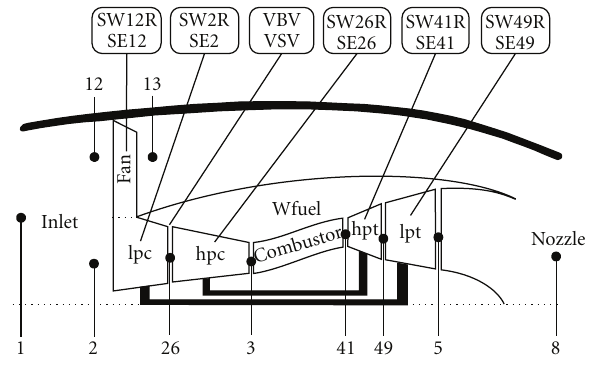
Figure 4: Turbofan layout with station numbering and health parameter locations.